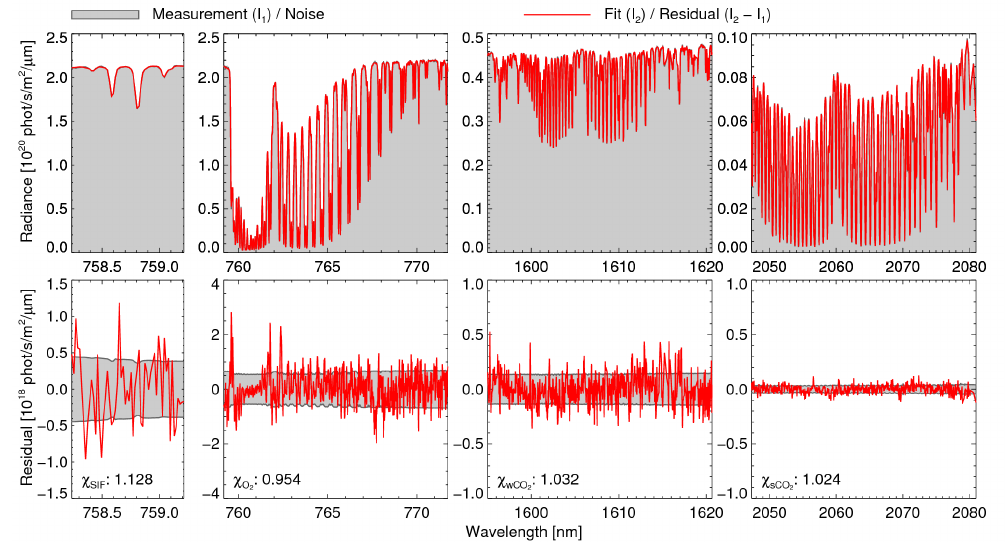
Figure 1. OCO-2 measurement of June 6, 2015, 12:01 UTC near Hamburg, Germany (sounding ID: 2015060512011938) fitted with FOCAL. ( Top ) Simulated and fitted radiance measurement in gray and red, respectively. ( Bottom ) Adapted measurement noise (see Section 3.1) and fit residual (fit minus measurement) in gray and red, respectively; χ j is an estimate of the goodness of fit (relative to the noise) in fit window j and is computed as defined in part1